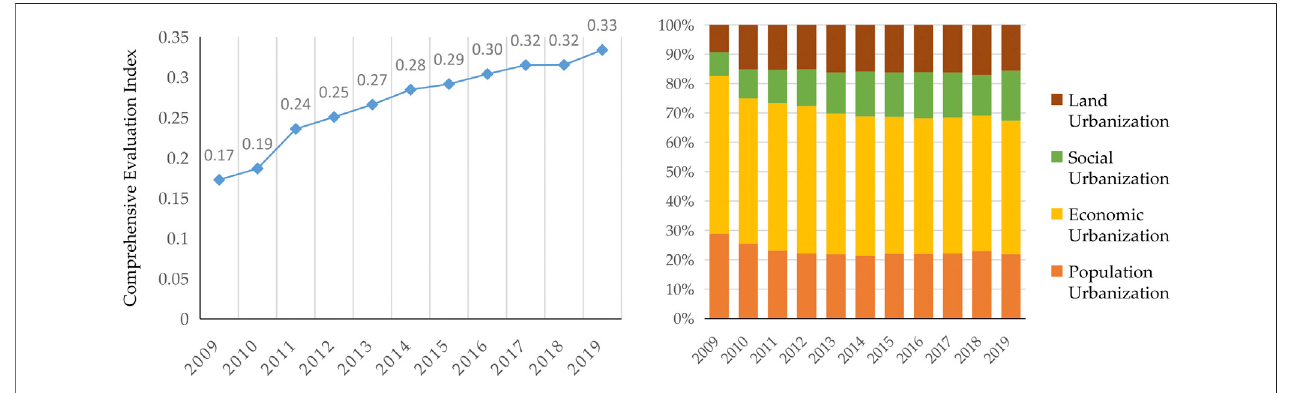
FIGURE 4 | Comprehensive evaluation of urbanization in Ningxia from 2009 to